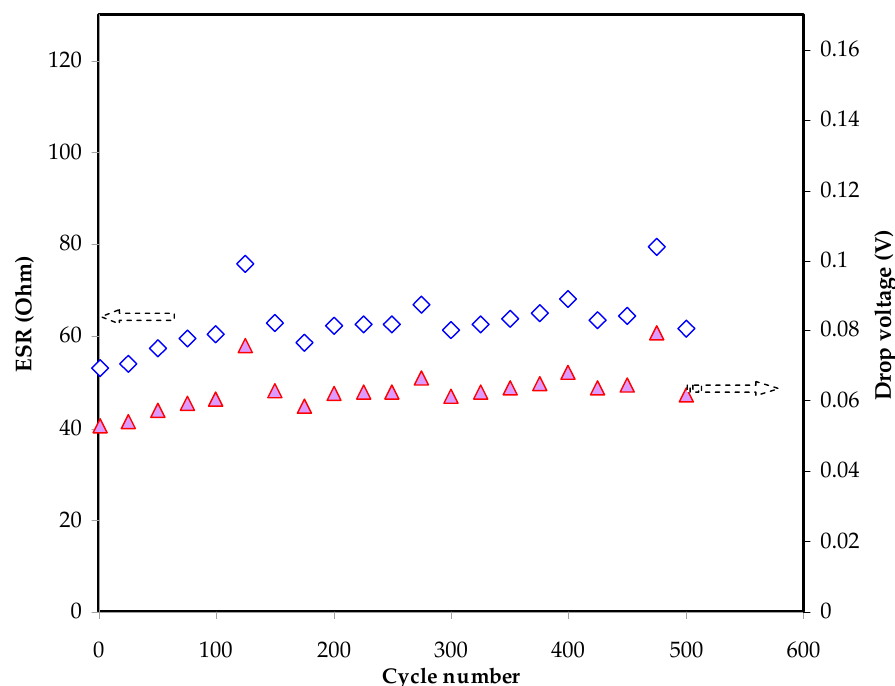
Figure 9. Equivalent series resistance (ESR) and drop voltage of the EDLC for 500 cycles of charging and discharging.